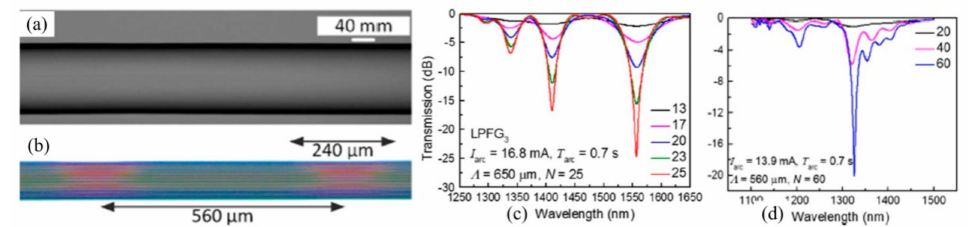
Figure 19. Side-view microscope images of fabricated SLPFG in ( a ) SMF and ( b ) PCF; transmission spectrum of the SLPFG in ( c ) SMF and ( d ) PCF [36].